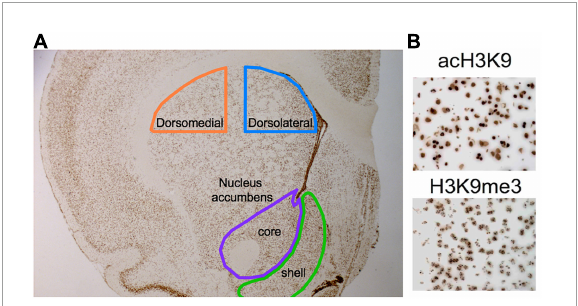
FIGURE2 Histone modification quantification visualization. A